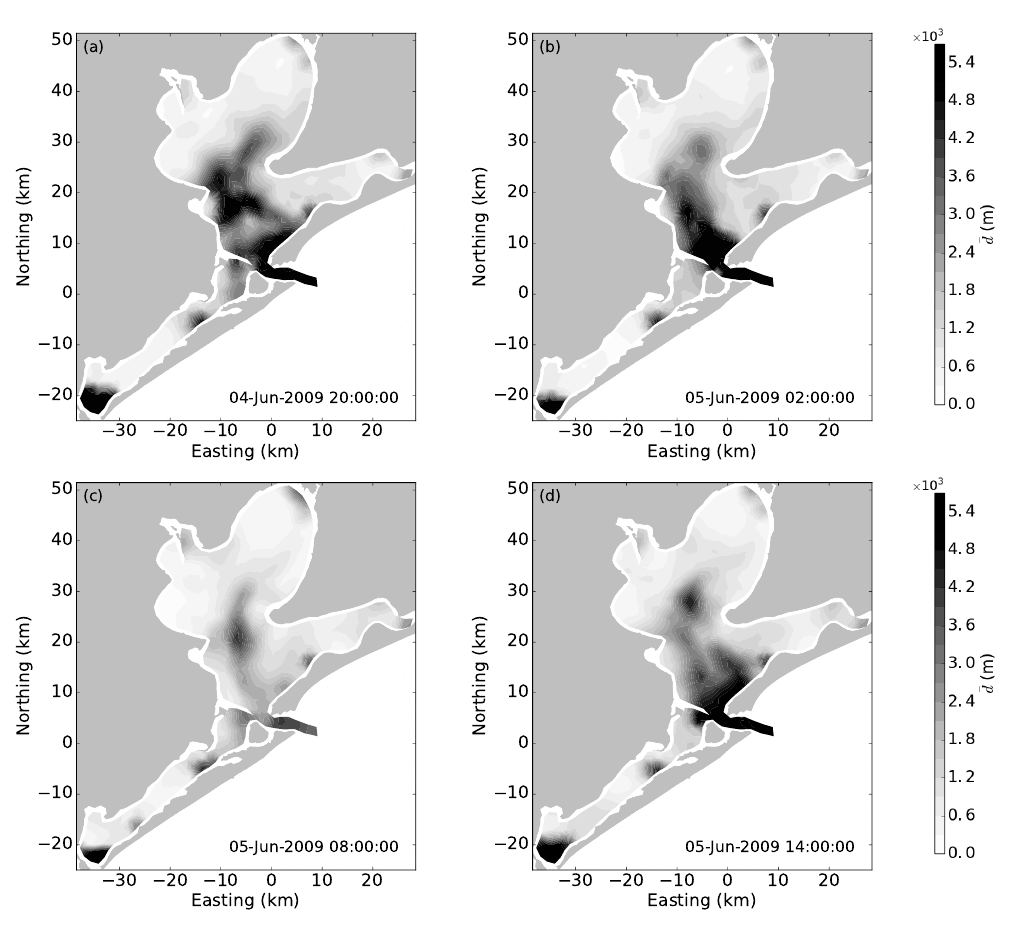
Figure 4. Spatial distribution of separation distance ( ¯ d ) at four flow conditions: ( a ) maximum flood tide, ( b ) moderate flood tide, ( c ) weak ebb tide (near slack water), and ( d ) maximum ebb